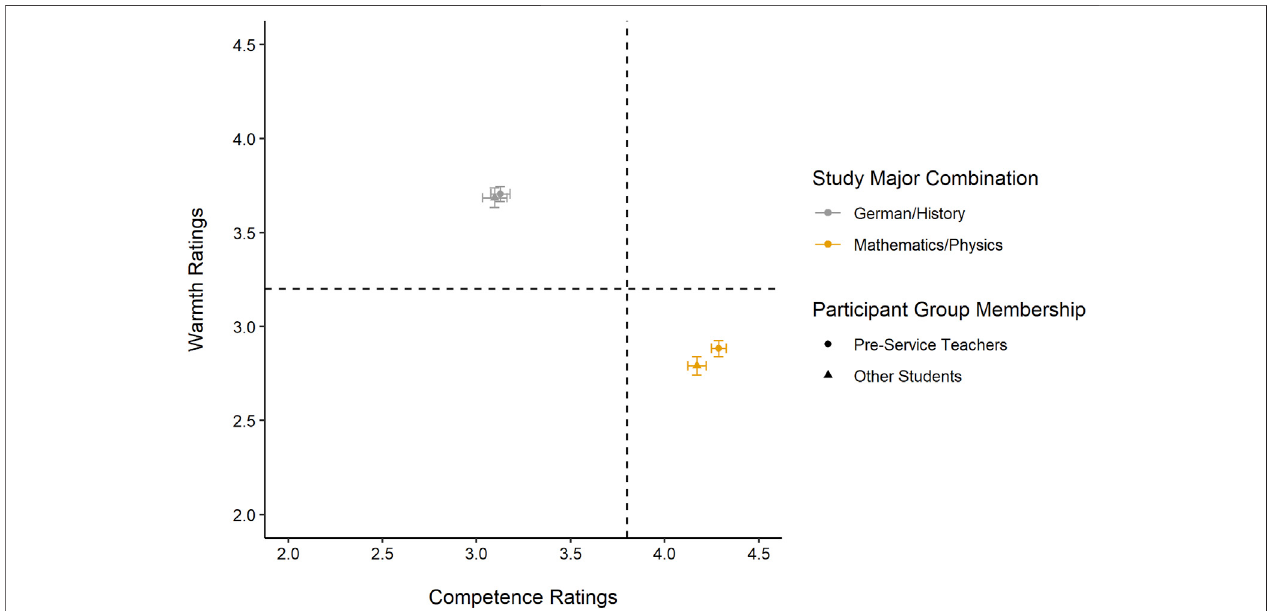
FIGURE 4 | Competence and Warmth Ratings by Study Major Combination and Participant Group Membership in Study 3b (Closed-Ended Questions). Note. Meancompetenceandwarmthratingsinclosed-endedquestionsfordifferentstudymajorcombinationsonascalefromoneto fi veareshownforparticipantsbelonging tothegroupsofpre-serviceteachersandotherstudents.Errorbarsrepresent standarderrors.Dottedlinesrepresent themediansofthecompetenceandwarmth